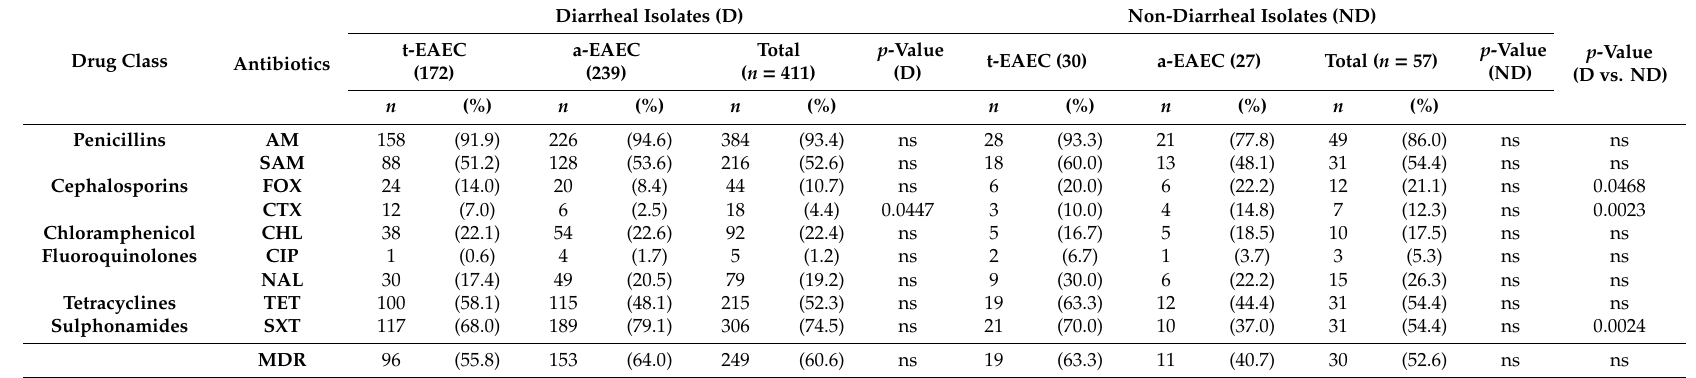
Table 4. Prevalence of antimicrobial resistance (AMR) phenotypes of EAEC isolated from diarrheal and non-diarrheal cases among Bolivian children. ns = nonsignificant.